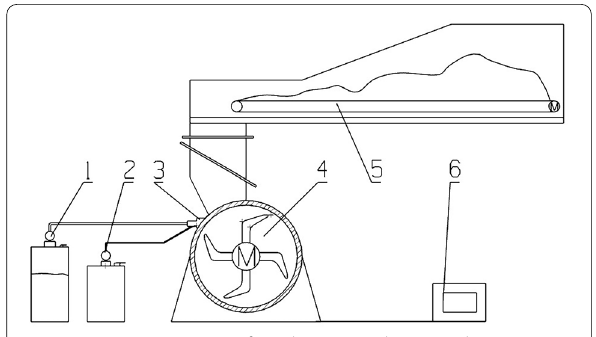
Fig. 1 Major components of PB gluing: 1. multi-pump dosing system; 2. air pressure pump; 3. atomization spray head; 4. blender; 5. belt scale; 6. micro-computer controller